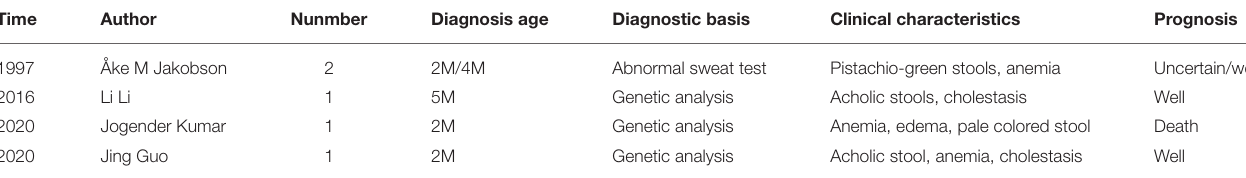
TABLE 2 | Results of literature